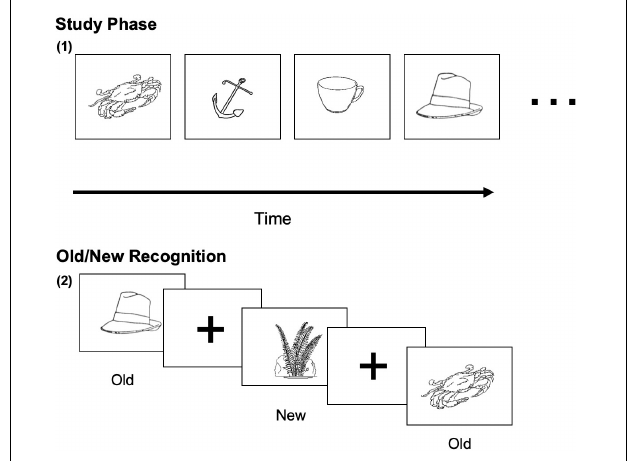
FIGURE 1 | Sample visual stimuli of the Old/New Task. (1) The studied (Old) visual object image (5 s each); (2) Old/New decision on studied and new (non-studied)